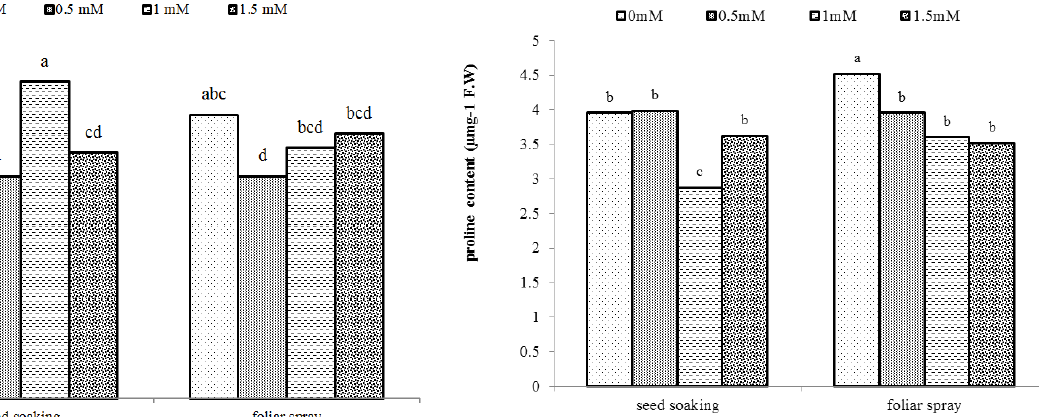
Fig. 4. Effect of SA and its application method on electrolyte leakage of watermelon seedling subjected to chilling stress. Val- ues followed by different letters were significant difference ac- cording to Duncan’s Multiple Range Test at p < 0.05